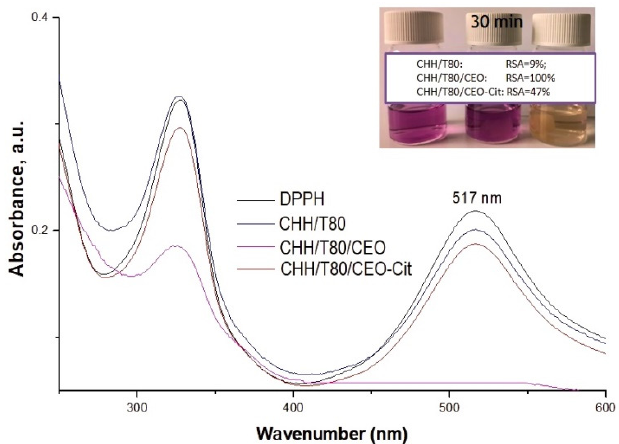
Figure 12. UV-Vis spectra and photographs of DPPH solutions free or incubated with chitosan- based xerogels (CHH/T80), loaded with clove essential oil (CHH/T80/CEO) and citrate cross-linked (CHH/T80/CEO-Cit).